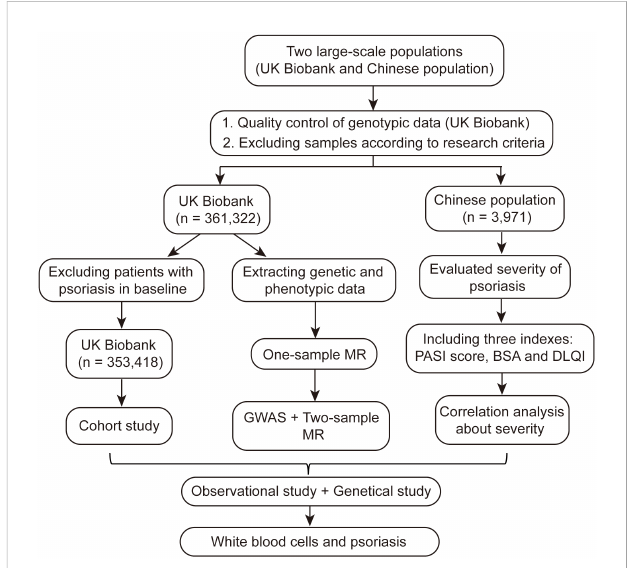
FIGURE 1 Flowchart of the study about white blood cells and